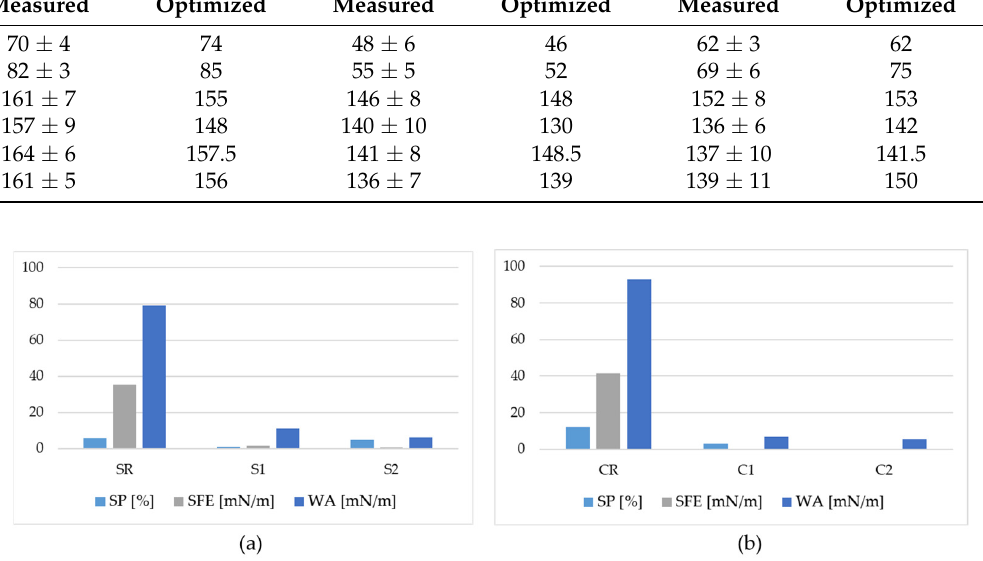
Figure 7. Water CA measurements on CR, C1, and C2 ( top ) and SR, S1, and S2 samples ( bottom ). Table 2. Experimentally measured CA; the optimized values are also reported.